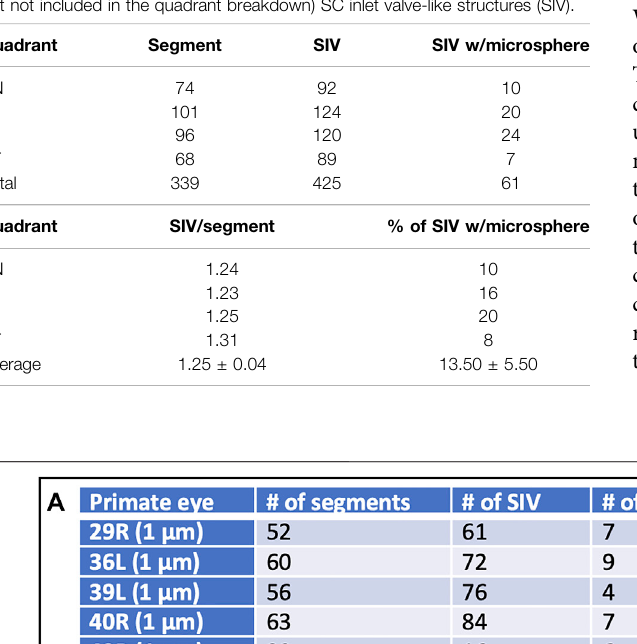
Frontiers in Cell and Developmental Biology |